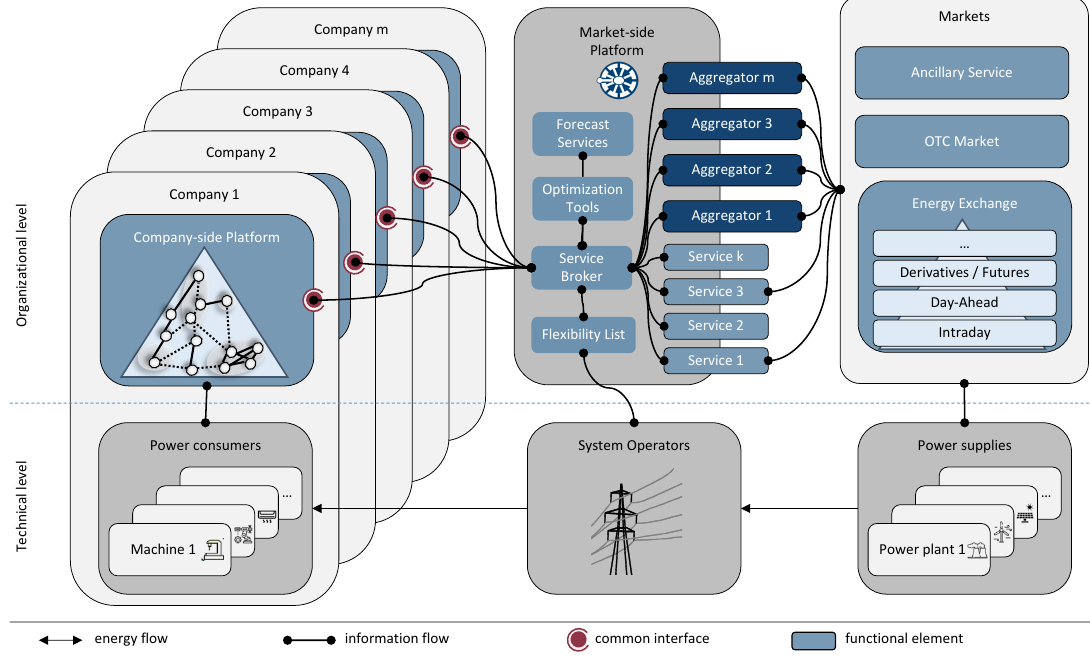
Figure 5. End-to-end approach of the energy synchronization platform integrating IT platforms, services, aggregators, and energy